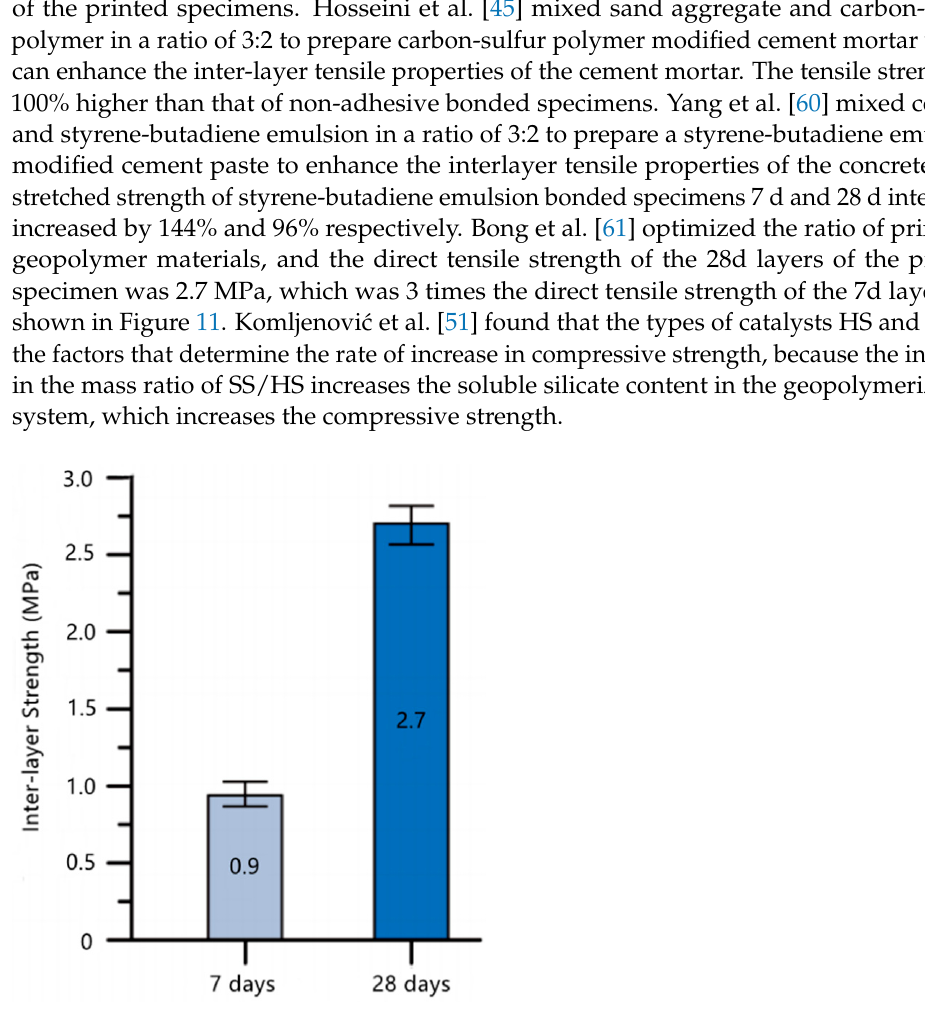
Figure 11. Interlayer bond strength of Na-N-2.5 (the optimum 3D printable mixture). Reprinted with permission from ref. [61]. Copyright 2019 Table 2. The effect of different cementitious materials on components.